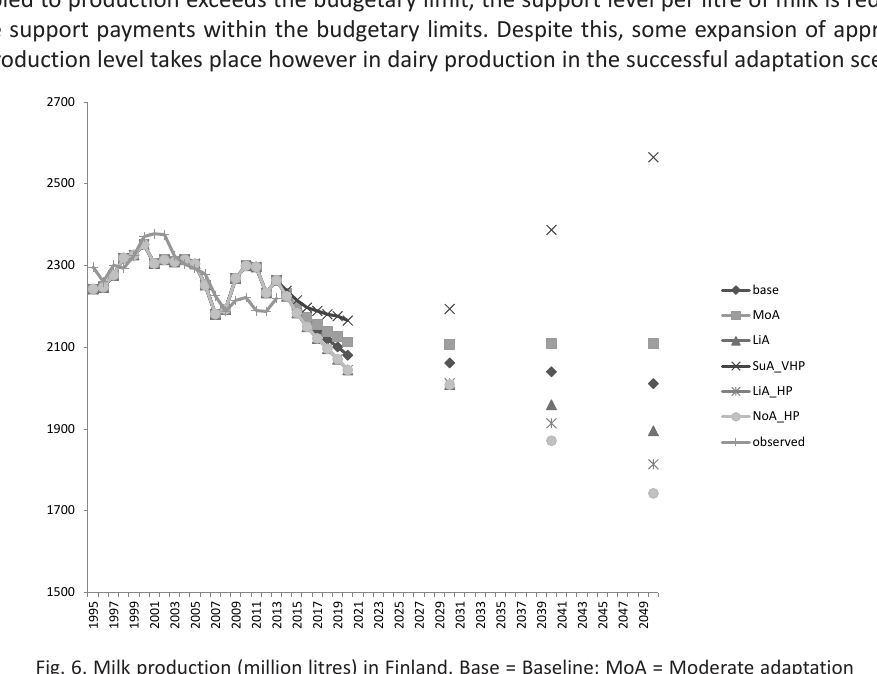
Fig. 6. Milk production (million litres) in Finland. Base = Baseline; MoA = Moderate adaptation (yields +10%); LiA = Little adaptation (yields –10%); SuA_VHP = Successful adaptation, very high prices (yields +30%, crop prices+30%); LiA_HP = Little Adaptation, high prices (yields –10%, crop prices +10%); NoA_HP = No adaptation, high prices (yields –20%, crop prices +10%). Observed = milk production, according to official